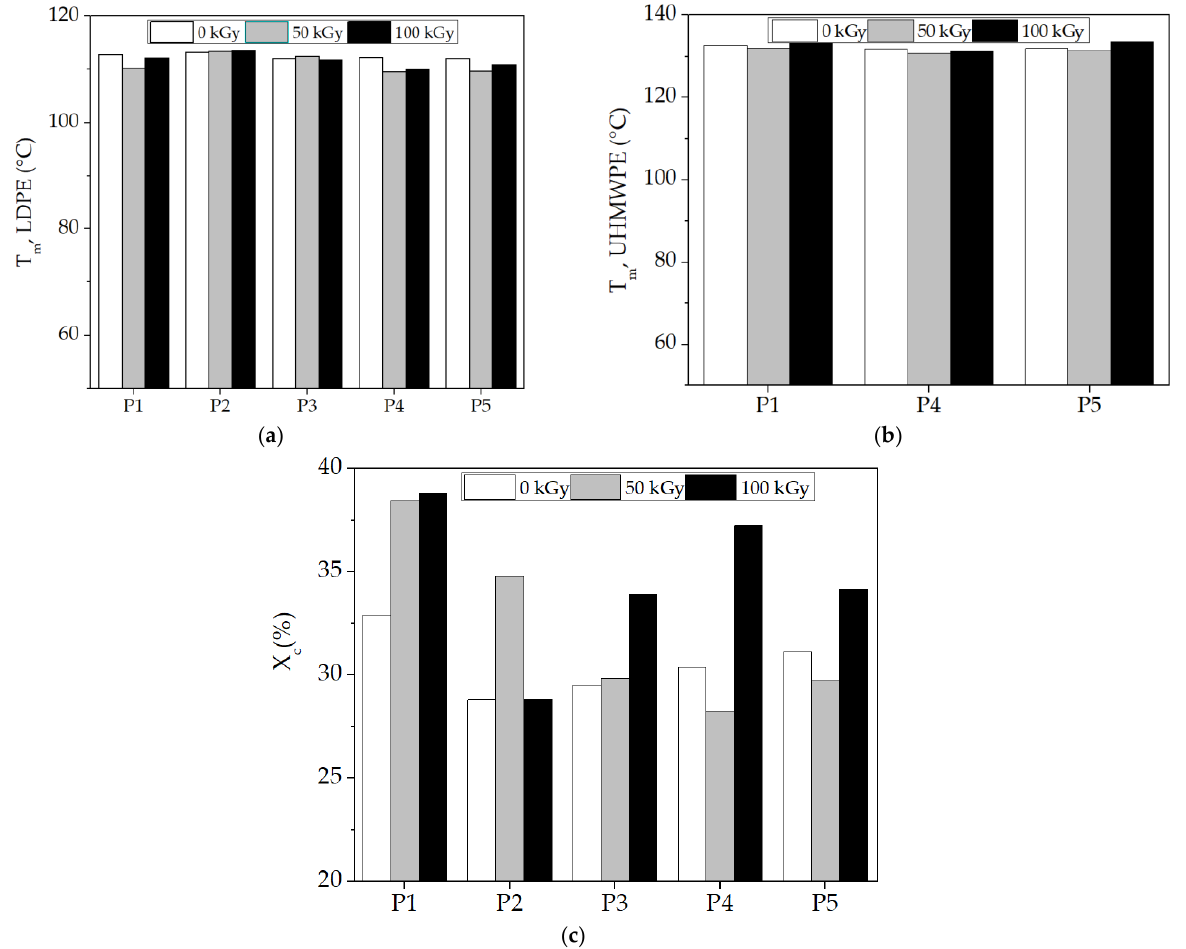
Figure 9. DSC parameters plotted as melting temperature at different γ -doses. ( a ) T m for LPDE, ( b ) T m for UHMWPE, and ( c ) total degree of crystallinity (X c ). (P1) LDPE/UHMWPE; (P2) LDPE/Hap; (P3) LDPE/HAp/RM; (P4) LDPE/UHMWPE/HAp; (P5) LDPE/UHMWPE/HAp/RM.